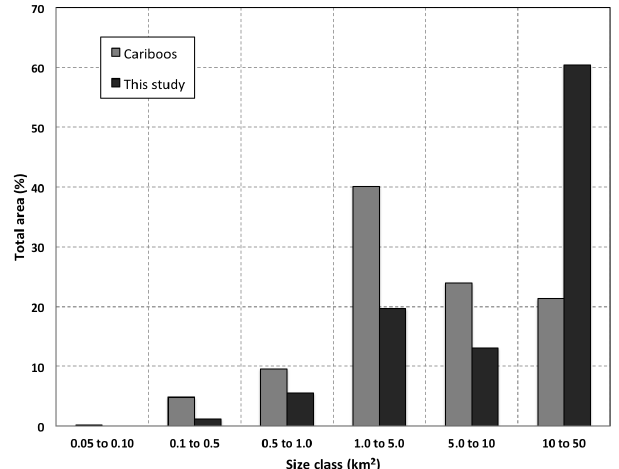
Figure 4. Fraction of total glacierized extent by size class for all Cariboo Mountains glaciers (gray) and this study